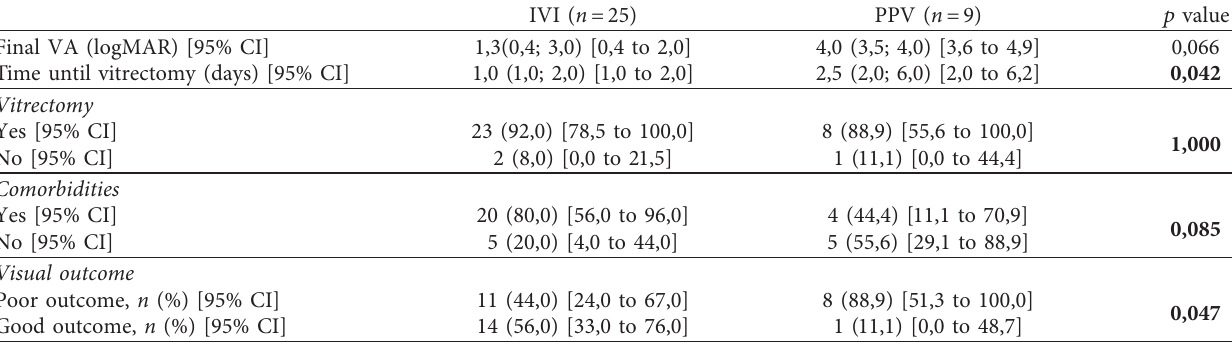
Poor outcome, n (%) [95% CI] Values are displayed as median (IQR) for continuous variables and number (%) for categorical variables. Comparisons were made with nonparametric Kruskal–Wallis test following Dunn–Bonferroni post hoc test. The level of statistical significance was set at p < . 05. Poor outcome was classified as VA worse than or equal than counting fingers (CF) and good outcome classified as VA better than CF. PPV � pars plana vitrectomy; IVI � intravitreal injection; VA � visual acuity; logMAR � logarithm of the minimal angle of resolution. Table 4: Variable comparison and analysis of presumed endophthalmitis cases ( n � 61) after cataract surgery and intravitreal injections (IVI) in Centro Hospitalar Universit´ario de São João. Cataract surgery ( n � 27) IVI ( n � 25) p value Final VA (logMAR) [95% CI] Time until vitrectomy (days) [95% CI]